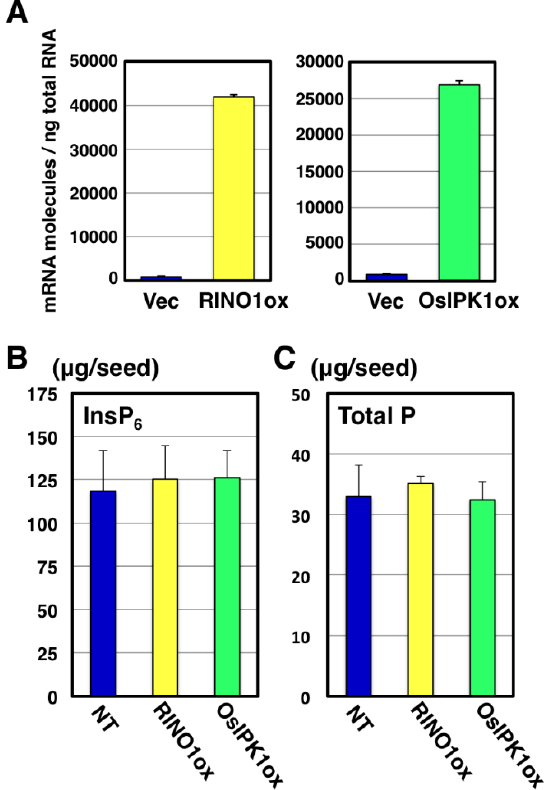
Figure 2. Gene expression and seed phenotype of RINO1ox and OsIPK1ox transgenic plants. ( A ) Quantitative RT-PCR analysis of RINO1 (left) and OsIPK1 (right) genes with cDNA templates from leaves of vector control (Vec) and RINO1ox or OsIPK1ox plants 7 d after germination ( n = 3); ( B ) InsP 6 content in mature seeds obtained from non-transformant (NT) and two transgenic plants was determined by ion chromatography ( n ≥ 7); ( C ) Total P content in NT and two transgenic seeds was measured by colorimetric assay ( n ≥ 5). Each value ( A to C ) represents the mean ±